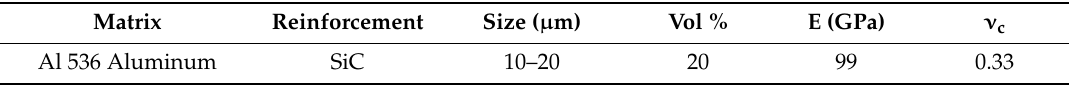
Table 1. Properties of the Al–SiC particle-reinforced composite.